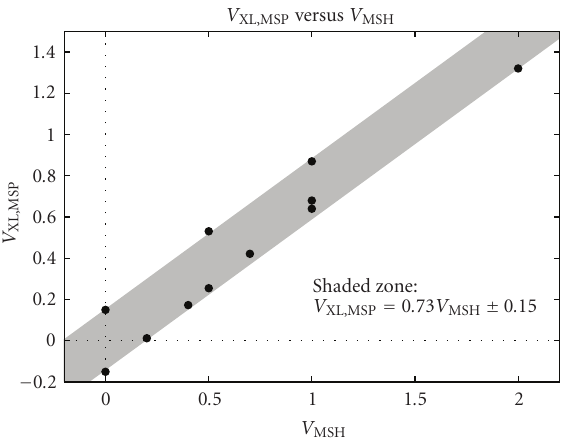
Figure 18: V MSH versus V L ,XL,MSP ( V L ,XL in the magnetosphere- rest frame). The X-line speed in the magnetosphere-rest frame is 0 . 73 V MSH ± 0 . 15 if the guide field e ff ects are taken as “error bars.”